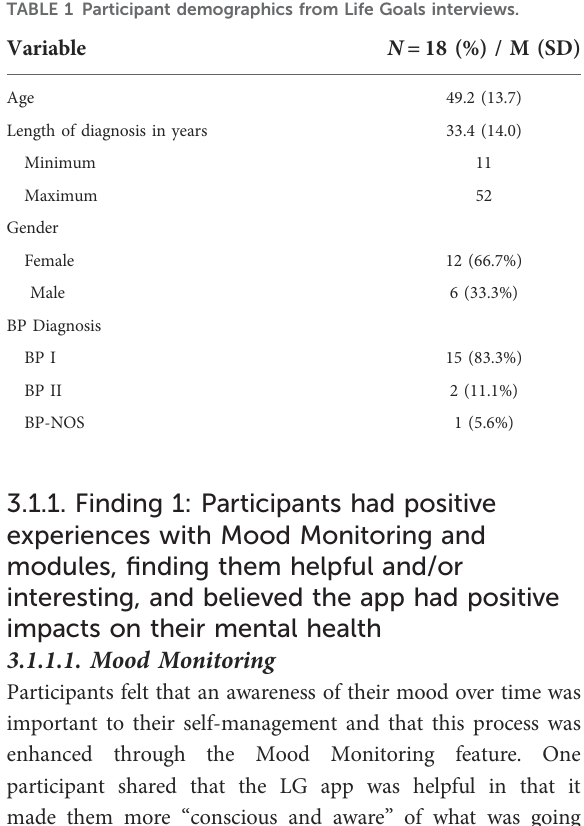
TABLE 1 Participant demographics from Life Goals interviews.